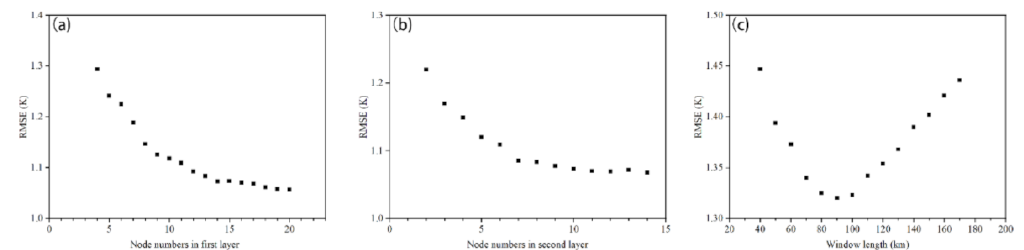
Figure A2. Sensitivity analysis of the node numbers of the two-layer multilayer perceptron model and the length of sliding window. ( a ) Performance change with the first hidden layer with the fixed node 10 in the second hidden layer. ( b ) Performance change with the second hidden layer with the fixed node 14 in the first hidden layer. ( c ) Performance change with the window length with the fixed sliding distance 10 km (one grid’s size). The RMSE is calculated from the comparison of the test sets (15% of the training dataset) and their corresponding predictions in the MLP model. Considering the computing time cost, the final nodes in two layers are chosen to be 14 and 7, and the window size is 90 in the MLP process.